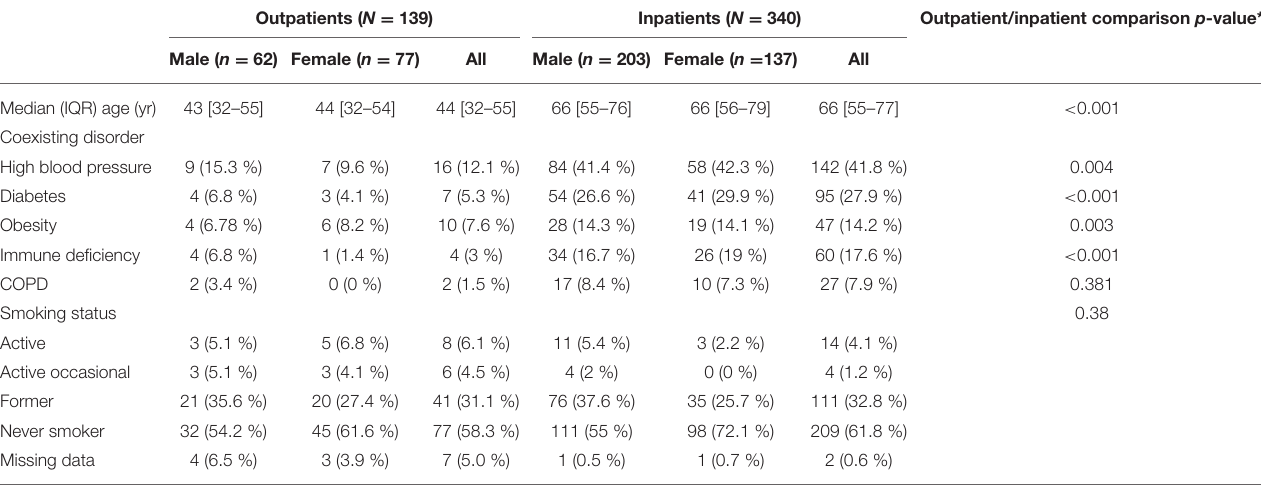
TABLE 1 | Clinical characteristics and smoking habits of patients with COVID-19. Outpatients ( N = 139) Inpatients ( N = 340) Outpatient/inpatient comparison p